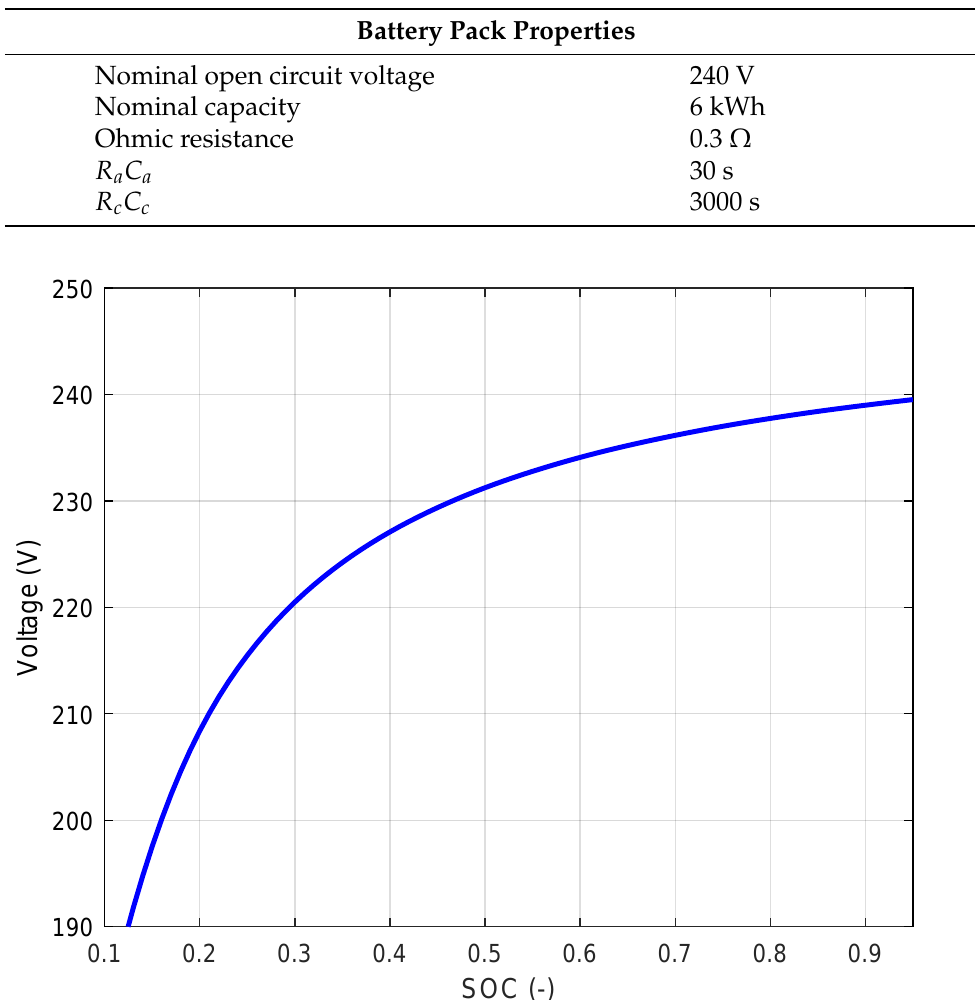
Figure 11. Battery pack voltage as function of the